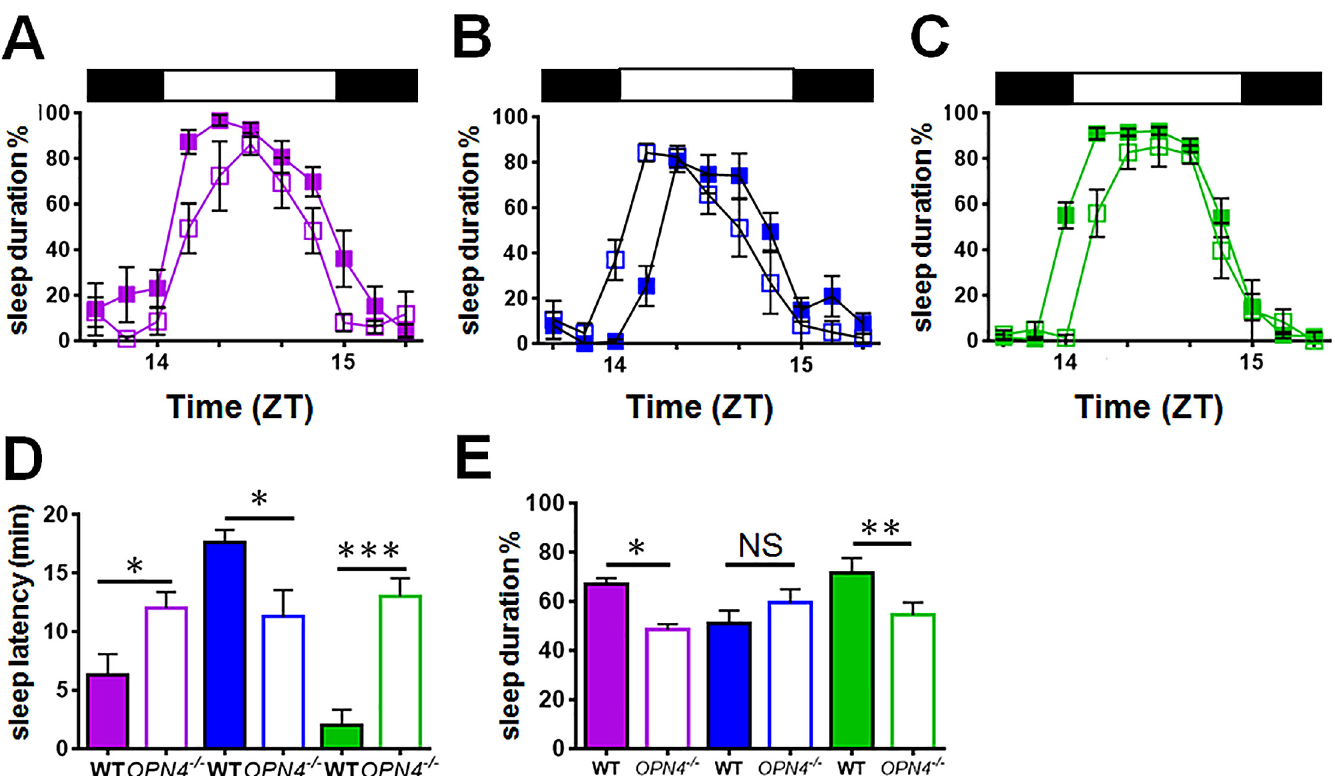
Fig 2. Wavelength-dependent effects of light on sleep are abolished in melanopsin-deficient ( Opn4 -/- ) mice. ( A – C ) Sleep induction in response to violet ( A ), blue ( B ) and green ( C ) light. Sleep was studied in Opn4 -/- mice (open symbols, n = 6 – 10/group) and compared with wildtype mice (WT, solid symbols). ( D ) In comparison with wildtype mice, Opn4 -/- mice show delayed sleep onset in response to green and violet light but advanced sleep onset in response to blue light. Two-way ANOVA for wavelength and genotype, wavelength x genotype interaction F (2,43) = 12.143, p (cid:1) 0.001. Posthoc Tukey wildtype versus Opn4 -/- violet p = 0.011, blue p = 0.013, green p (cid:1) 0.001. Comparison of Opn4 -/- responses in sleep induction as well as duration show no statistical differences due to wavelength. ( E ) However, in comparison to wildtype mice Opn4 -/- mice exposed to green and violet light show reduced sleep duration. Two-way ANOVA for wavelength and genotype, wavelength x genotype interaction F (2.44) = 5.142, p = 0.010, posthoc Tukey wildtype versus Opn4 -/- violet p = 0.017, blue p = 0.259, green p = 0.003. Despite the difference in sleep onset under blue light in Opn4 -/- and wildtype mice, there was no difference in sleep duration. Solid horizontal bars illustrate light pulse duration from ZT14 until ZT15. Data plotted as mean ± SEM. Significant differences indicated by *** p (cid:1) 0.001, ** p (cid:1) 0.01, * p (cid:1) 0.05, NS = not significant. The data used to make this figure can be found in S2 Data.